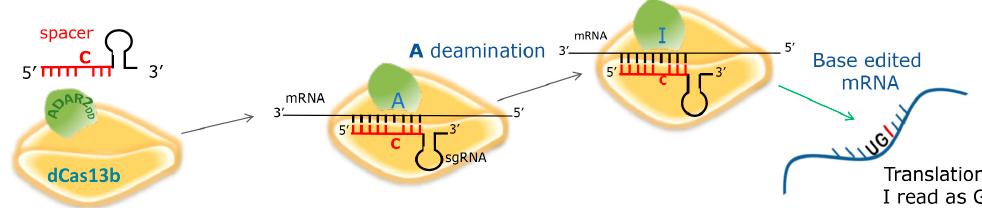
Figure 1. Schematic representation of mRNA editing by REPAIRv2; sgRNA: Specific guide RNA. The C:A mismatch at the target position and the outcome of editing, A to I replacement in the mRNA, are shown.